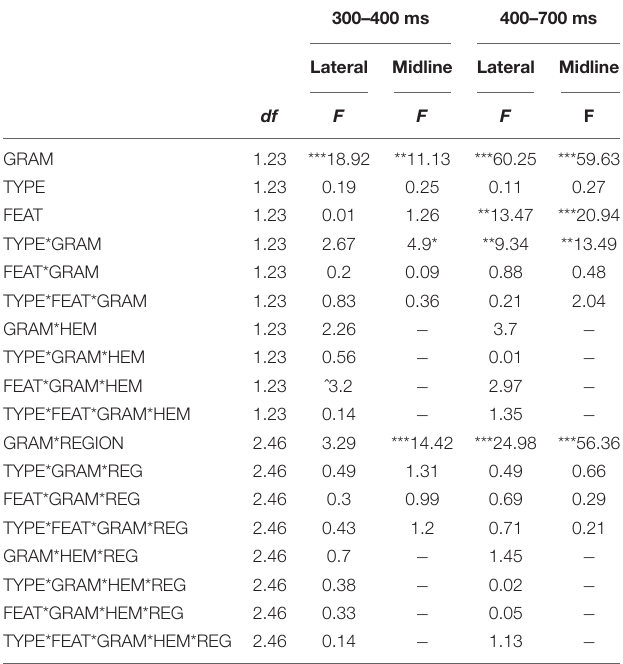
TABLE 3 | Summary of the ERP results.